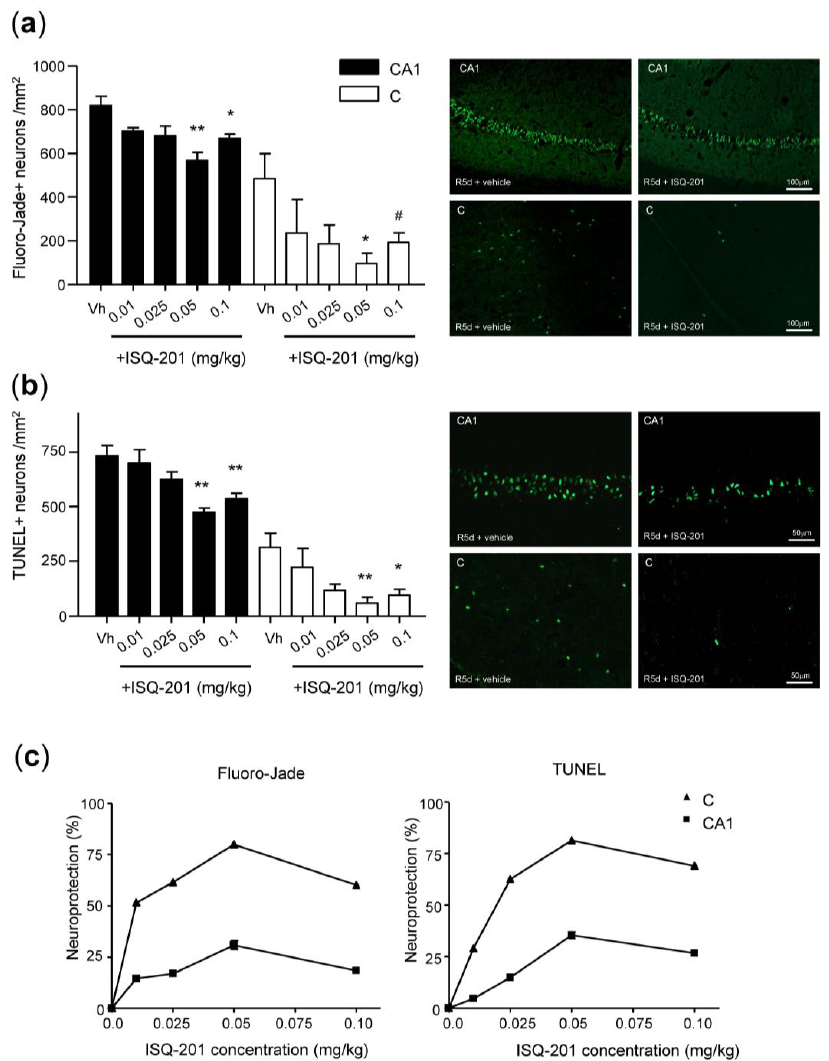
Figure 2. Dose-response curve of ISQ-201. Ischemic animals were treated with a vehicle or ISQ-201 (range 0.01–0.1 mg / kg) by an intravenous injection, at the onset of reperfusion after global cerebral ischemia, and ISQ-201 e ff ect was evaluated by assessing the neuronal death at 5 days of reperfusion (R5d). ( a ) Brain sections from vehicle- and ISQ-201-treated animals (R5d + vehicle and R5d + ISQ-201, respectively), were fixed and stained with Fluoro-Jade B to detect neuronal death. Fluoro-Jade-positive dead neurons were visualized by fluorescence microscopy (in green) in the hippocampal CA1 (CA1) and cortical (C) regions (images), and counted, as described in Materials and Methods (bar graph). ( b ) Brain sections as in ( a ) were used for apoptosis detection by TUNEL assay after fixation, and were visualized by fluorescence microscopy (in green) in the CA1 and C regions (images). TUNEL-positive cells were counted in the CA1 and C regions, as described in the Materials and Methods (bar graph). In ( a ) and ( b ), images are representative results of CA1 or C regions from vehicle- and ISQ-201-treated (0.05 mg / kg) animals. In bar graphs, data represent the mean of 6 − 11 independent animals per group, and the error bars indicate the SE. * p < 0.05 and ** p < 0.01, when compared with their respective R5d + vehicle (Vh), through Dunnett’s post-test, and # p < 0.05, when compared by Student’s t -test, after ANOVA. In ( c ), data from ( a ) and ( b ) are represented as neuroprotective activity of the di ff erent concentrations of ISQ-201. Neuroprotection was defined as the percentage achieved from the neuronal death or apoptosis value in the R5d + vehicle (Vh) (0% value), to the absence of neuronal death or apoptosis (100% value). Data are represented as mean ±